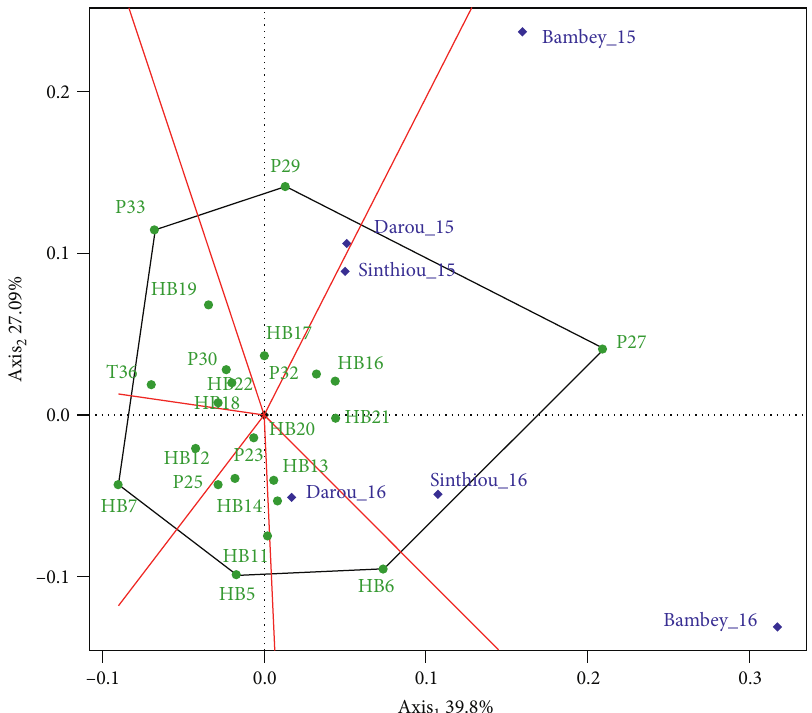
Figure 5: “Which-won-where” view of best grain mold tolerant inbred lines and hybrid combinations based on panicle grain mold resistance rating score. Red lines represent the megaenvironments; hybrids and inbred lines labels are written in green; locations labels are written in blue; dotted lines represent the axes.